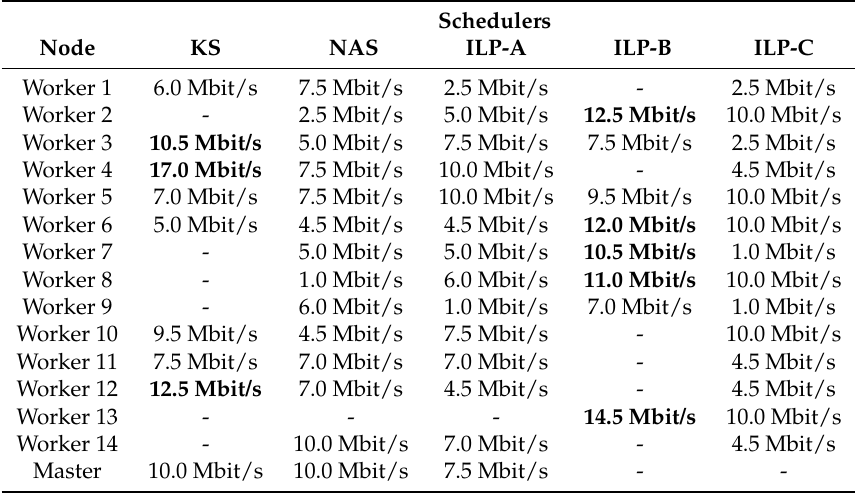
Table 8. The expected service bandwidth per node for the different scheduling